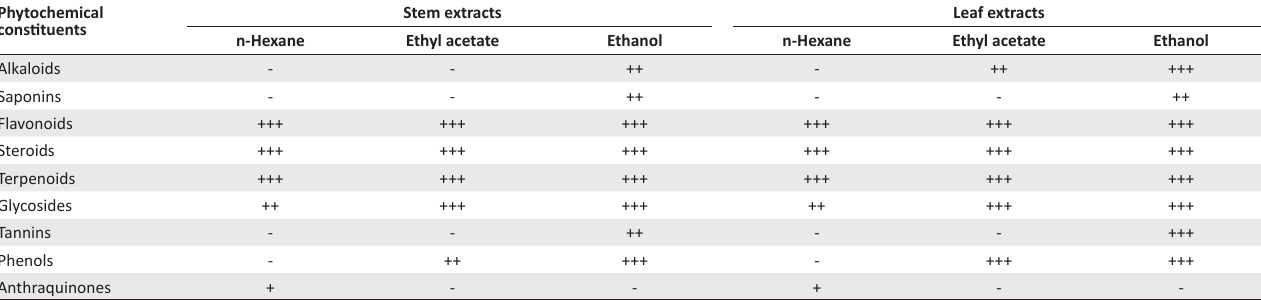
TABLE 1: Phytochemical composition of Pergularia daemia stem and leaf. Phytochemical constituents